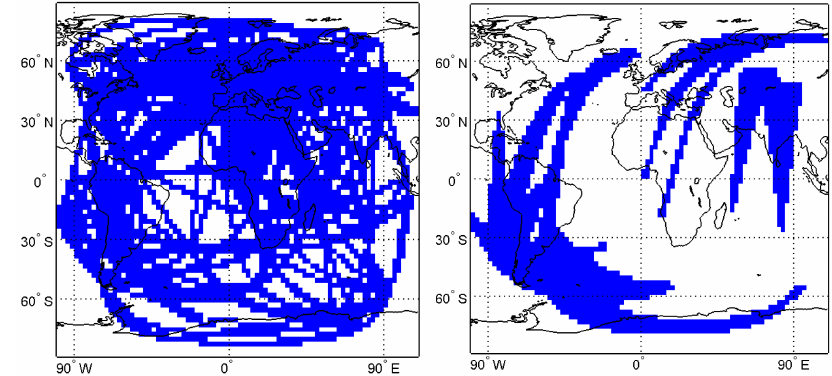
Figure 15. Coverage of the reconstructed array by space-based data (right) and by ground-based data (left) exemplarily on DOY 011 in 2011, 09:30UT. A pixel is coloured blue if at least one voxel above this pixel is intersected by at least one sTEC ray path.